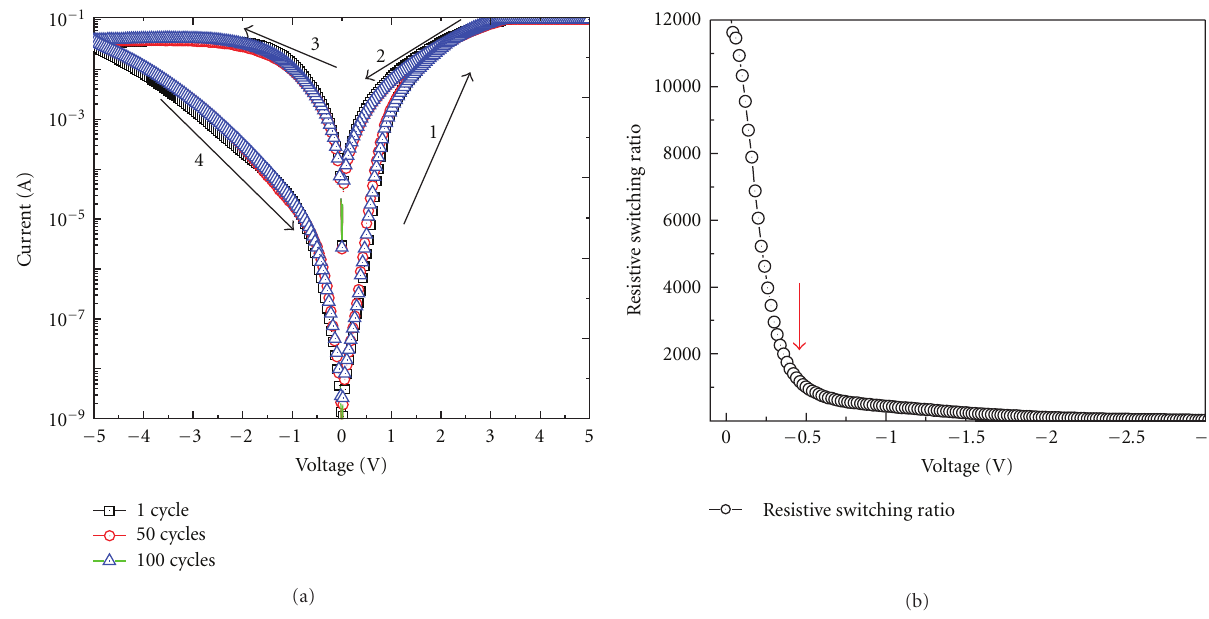
Figure 2: (a) Typical bipolar RS characteristics of Ag/NiO/NSTO/In device for the 1, 50, and 100 DC sweeping cycles. (b) The RS ratio dependence of the read voltages.